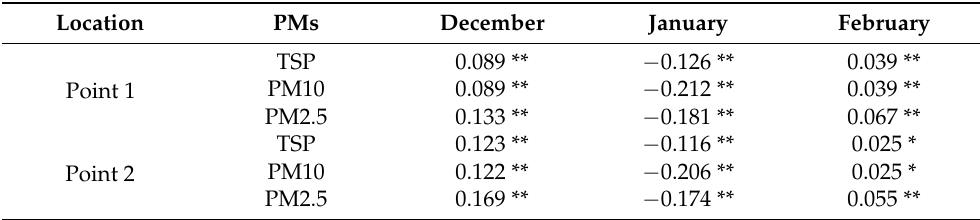
Figure 6. Monthly average temperature at both points. Table 9. Correlation coefficient between PMs and temperature at different locations.